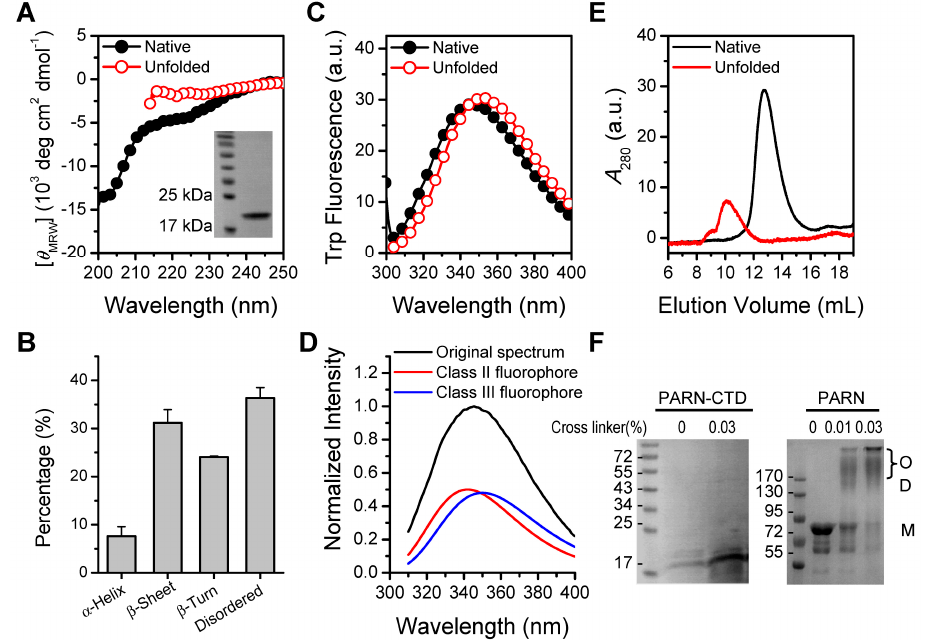
Figure 1. Structural features of poly(A)-specific ribonuclease C-terminal domain (PARN-CTD) . ( A ) Far-UV CD spectra of native PARN-CTD(541–639) and the unfolded state fully denatured by 6 M GdnHCl. The inset shows the SDS-PAGE analysis of the purified recombinant protein. ( B ) Percentages of various secondary structure elements estimated by CDPro. ( C ) Intrinsic Trp fluorescence excited at 295 nm. ( D ) Fitting of the experimental fluorescence spectrum of native PARN-CTD by the discrete state model of Trp residues in proteins. ( E ) SEC profiles of the native and unfolded proteins. ( F ) Analysis of the purified PARN-CTD by cross-linking using 0.03% glutaraldehyde by SDS-PAGE. Cross-linking of the full-length PARN, which exists as a dimer and high-order oligomers in solutions [49], was used as a positive control. M, monomer; D, dimer; O, oligomer. The molecular weight of the marker proteins are shown in kDa.